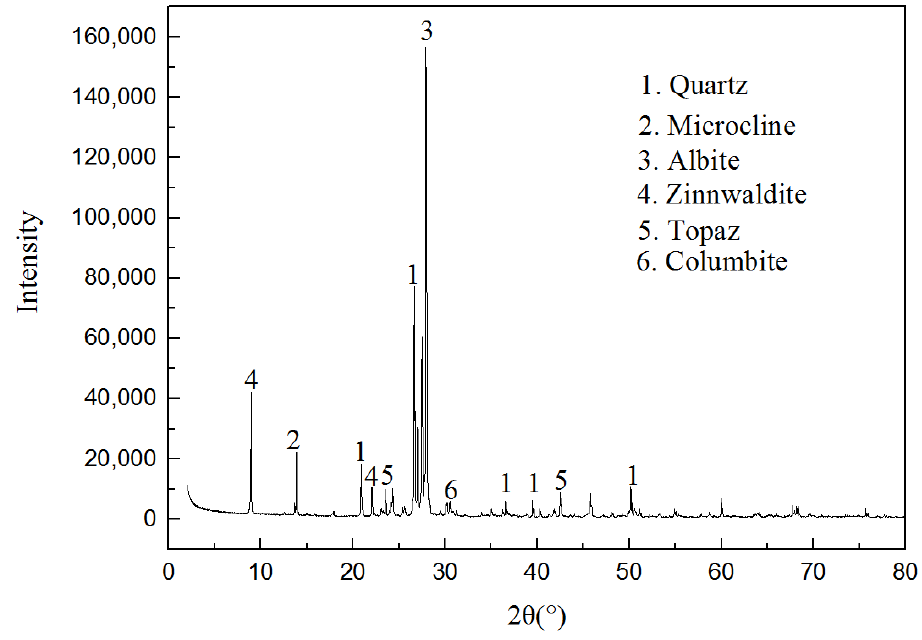
Figure 2. Results of X-ray diffraction analysis. Table 2. Mineral composition and content of the ore.